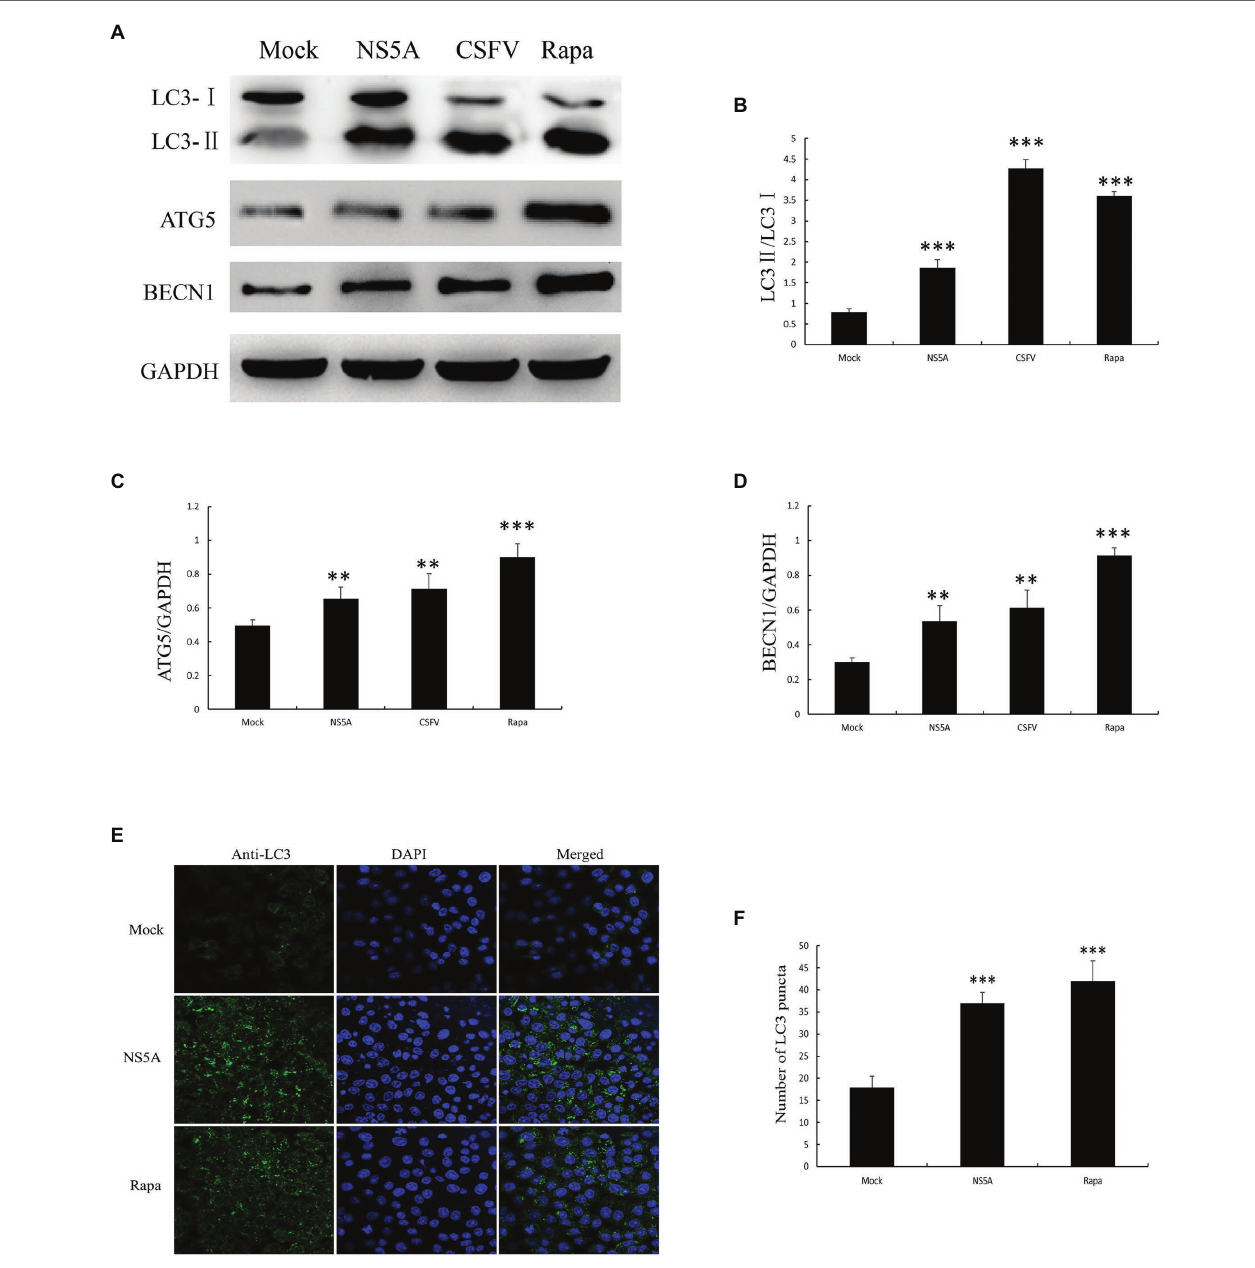
FIGURE 2 | Nonstructural protein 5A expression induces cellular autophagy. (A) PK-15 cells were transfected for NS5A expression, infected with CSFV (MOI = 1) for 36 h or treated with rapamycin (Rapa, 100 nM) for 48 h. (B-D) The expression of light chain 3 (LC3), ATG5, BECN1, and GAPDH (loading control) was analyzed by immunoblotting with specific antibodies described in the Materials and Methods. (E) PK-15 cells were transfected with NS5A or treated with Rapa (100 nM) for 48 h. The cells were then fixed and processed for indirect immunofluorescence using antibodies against LC3B, followed by the corresponding secondary antibodies conjugated to FITC as described in the Materials and Methods. The cell nuclei were counterstained with DAPI. The fluorescence signals were visualized by confocal immunofluorescence microscopy. In the images, nuclear staining is shown in blue, and LC3B staining is shown in green. (F) The average number of LC3B puncta in each cell was determined from at least 100 cells in each group. The data represent the mean ± SD of three independent experiments. Statistical comparisons were evaluated using ANOVA followed by Tukey’s HSD post hoc analysis. *** p < 0.001, ** p < 0.01, and compared with the mock